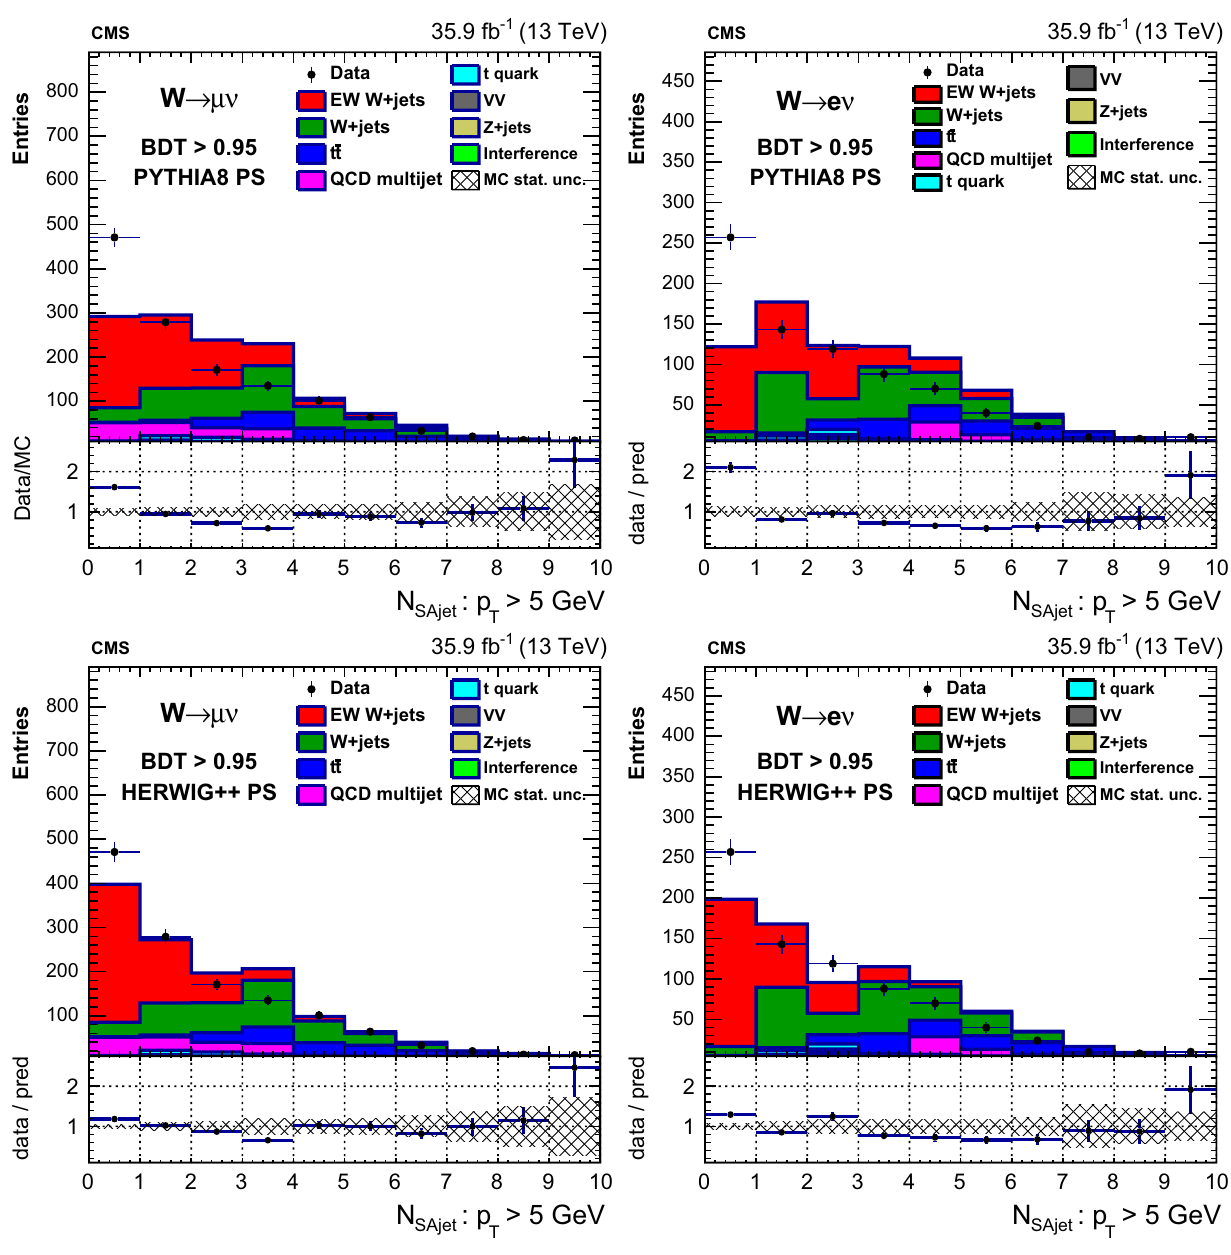
Fig. 21 Number of soft activity jets with p T > 5GeV in the rapidity gap for BDT > 0 . 95 in the muon (left) and electron (right) channels including signal with pythia parton showering (upper) and herwig++ parton showering